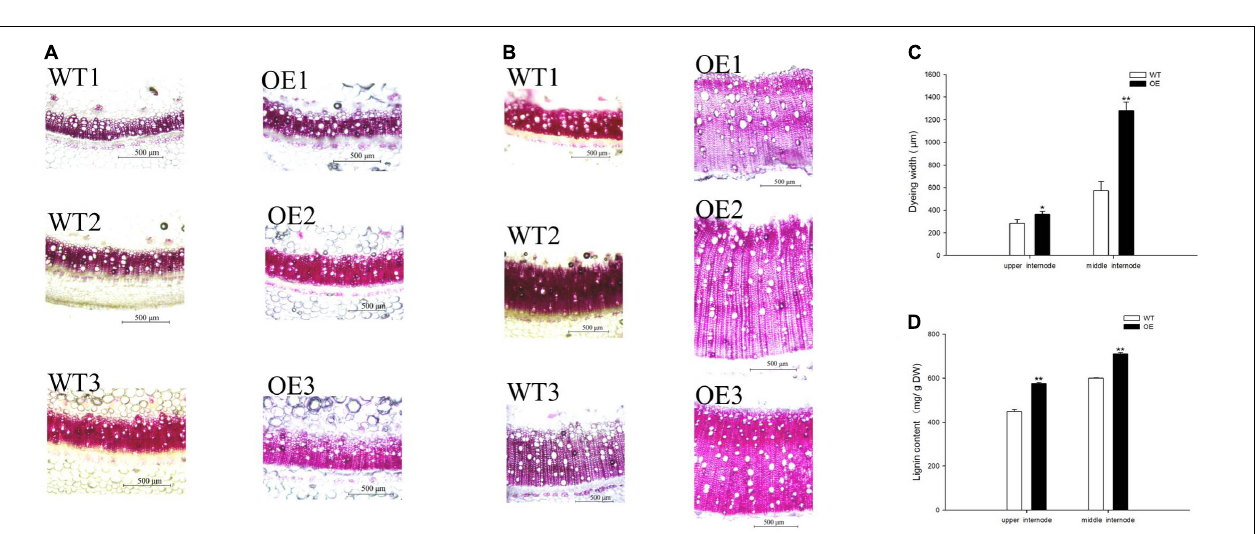
FIGURE 3 | PpCCoAOMT overexpression reduces stomatal number but increases stomatal area, length, and aperture under normal conditions. (A) Advanced upright optical microscopic images of the WT and OE lines. Bars = 100 µ m. (B) Image of a single stoma from the WT and OE transgenic lines. Bars = 20 µ m. Images were acquired using a BX51 bright-field microscope with a DP70 charge-coupled device camera (Olympus, Tokyo, Japan). (C) The number of stomata was calculated for each line using Image-Pro Plus 6.0 software. Data are means ( ± SDs) of 25 replicates. (D) Stomatal area, (E) stomatal length, and (F) stomatal aperture of the WT and OE transgenic tobacco lines were determined using Image-Pro Plus 6.0 software. Data are means ( ± SDs) of 35 replicates. A microscopic ruler (Olympus) was used to calibrate size. Significant differences between WT and OE lines were determined using independent samples t- tests. * P < 0.05, ** P < 0.01.